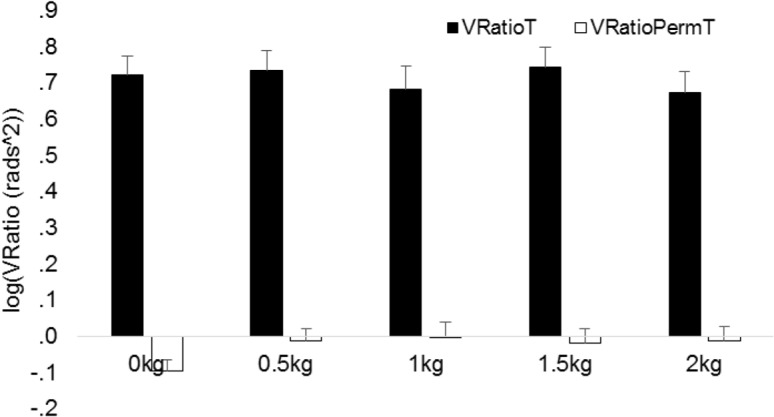
Log transformed VRatio (VRatioT) and VRatioPerm (VRatioPermT) averaged across ID and movement phases for all physical demand conditions.Vertical bars denote standard error of the mean.